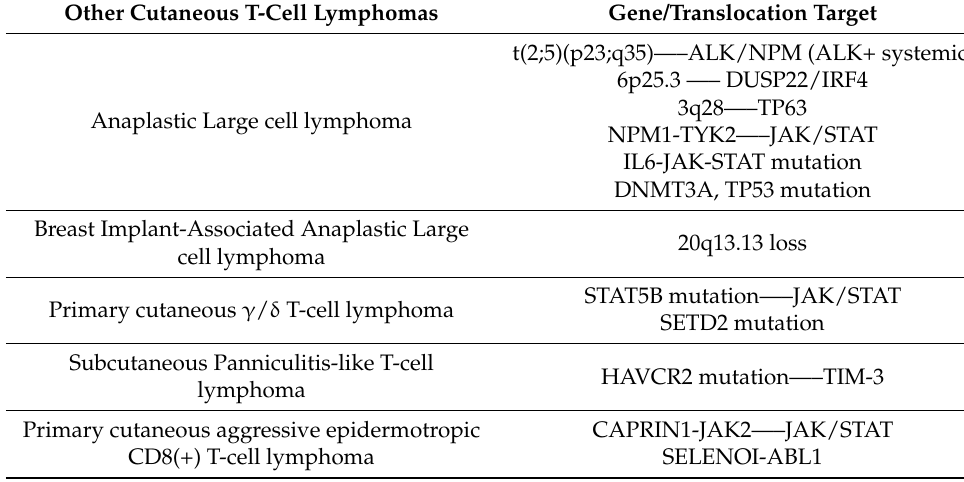
Summary of genetic abnormalities reported in cutaneous lymphomas other than MF/SS